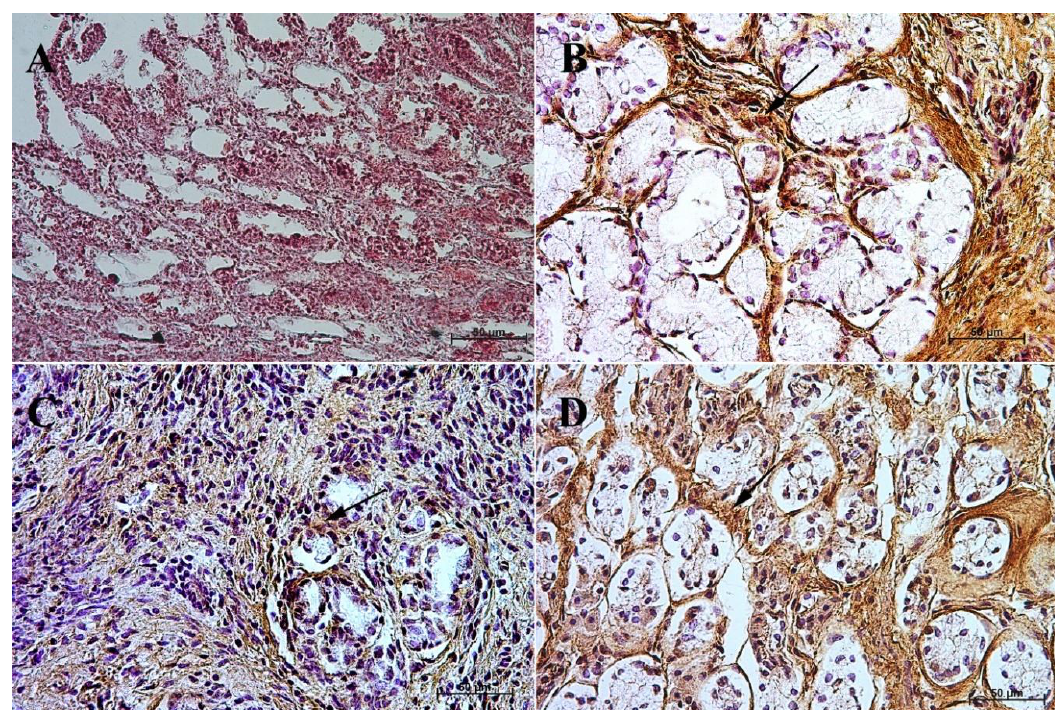
Figure 7. Immunoreactivity of anti-secretin receptor antibody in the fundic mucosa, 40×. ( A ) — the first age group, ( B ) — the second age group, ( C ) — the third age group, ( D ) — adult reference group. The arrow indicates positive immunohistochemical reaction.